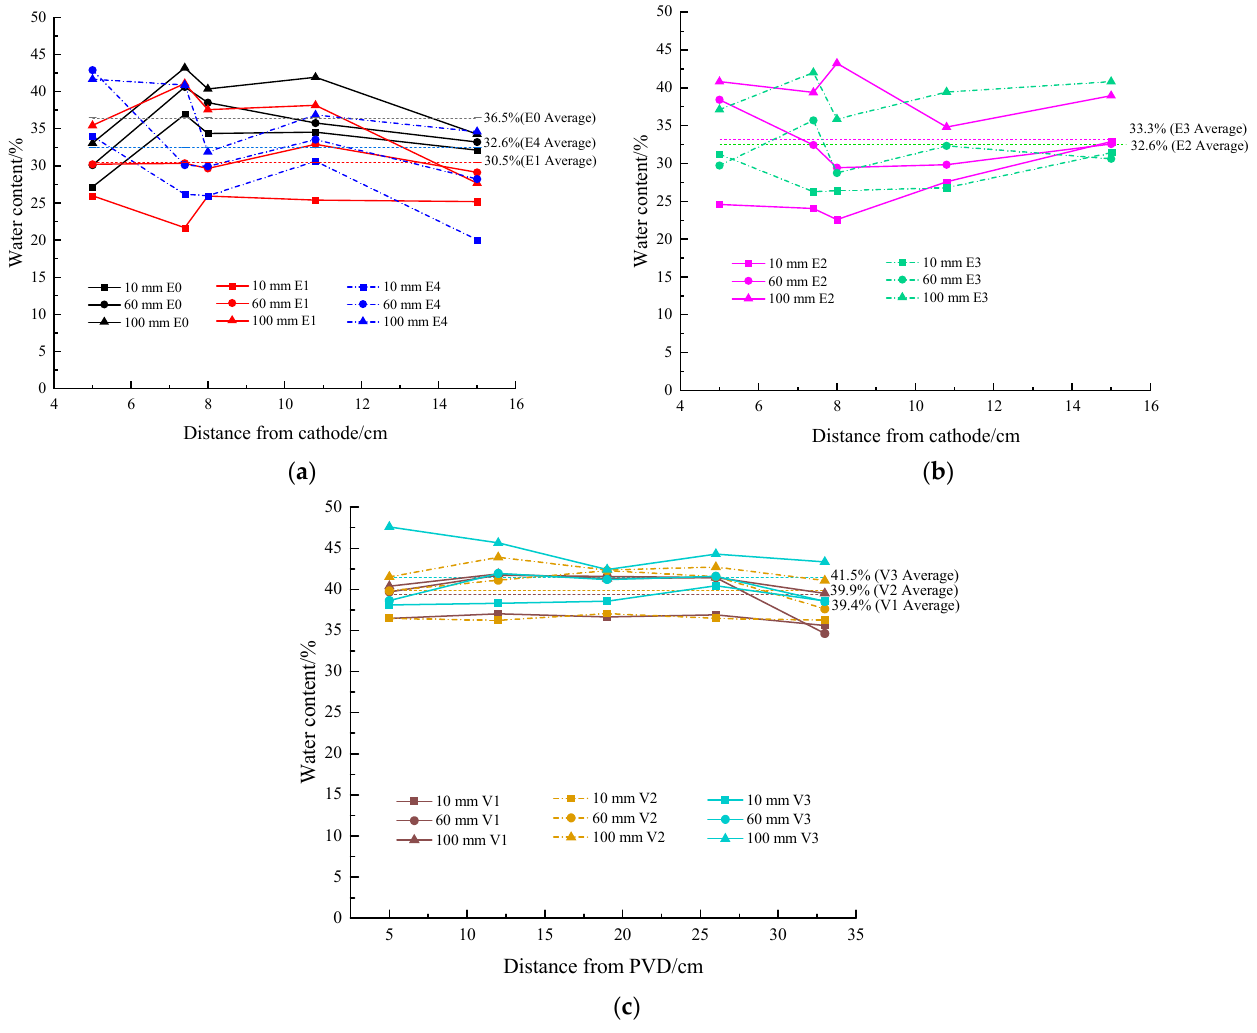
Figure 6. Water content of soil treated by EO and VP with different immersion duration: ( a ) E0, E1 and E4, ( b ) E2 and E3, ( c ) V1, V2 and V3.